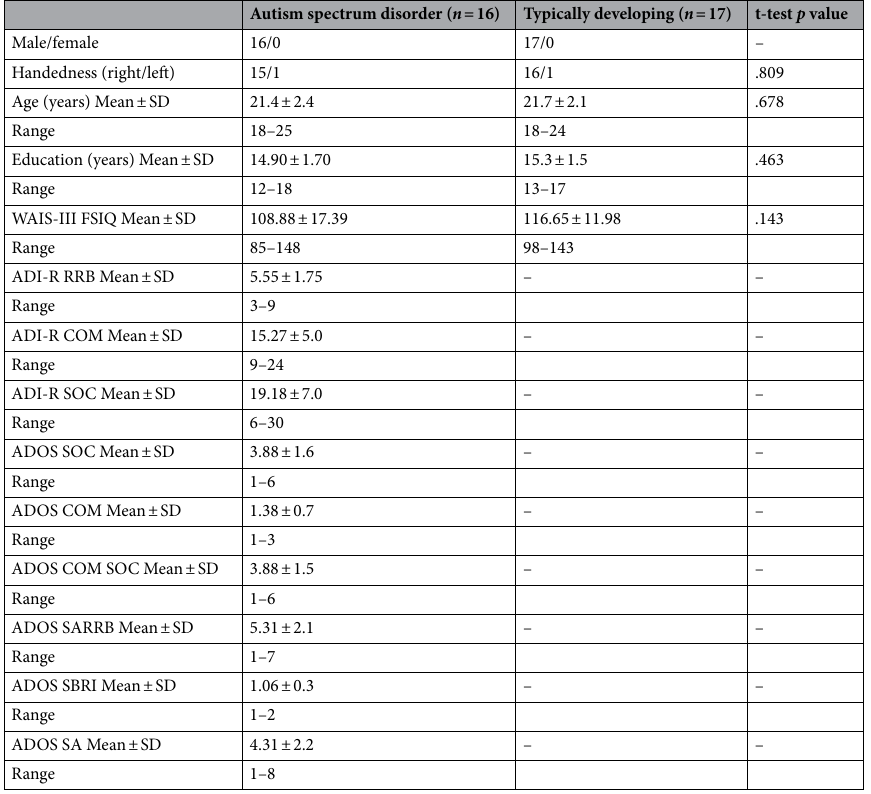
Table 1. Summary of demographic, IQ, ADIR, and ADOS severity scores of the participants in TD and ASD groups. ADIR Autism Diagnostic Interview-Revised, ADOS Autism Diagnostic Observation Schedule, FSIQ Full scale intelligence quotient, RRB Restrictive & repetitive behaviors, COM Communication, SOC Social Interaction, COM SOC Communication + Social Interaction, SARRB Social Affect & Restricted Repetitive Behaviors, SA social affect, SBRI Stereotyped behaviors and restricted